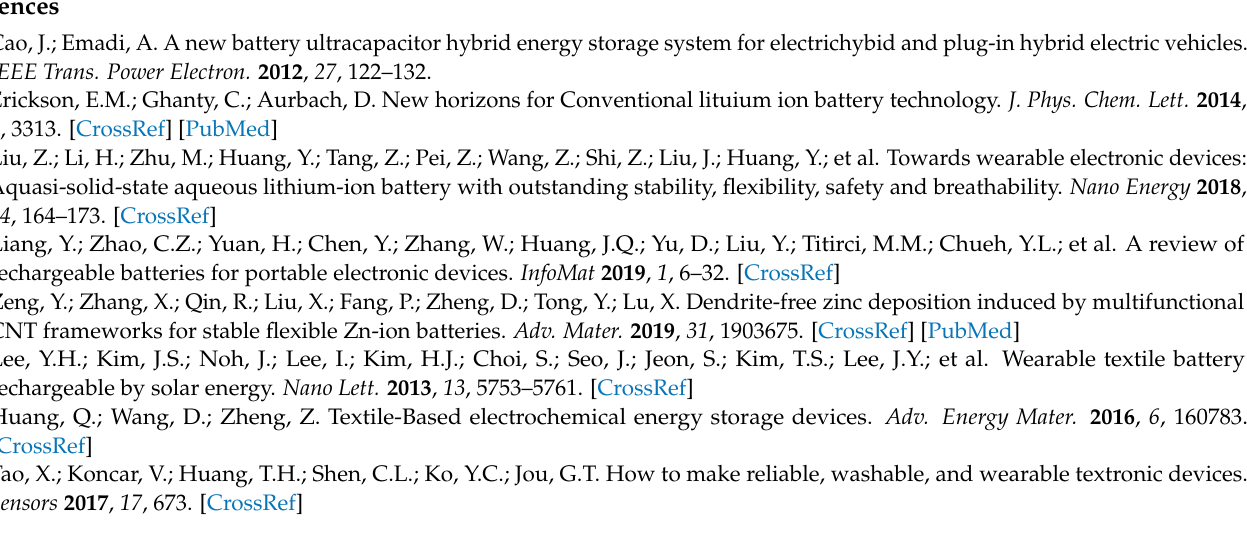
MnO 2 yarn cathode, Zn yarn anode., Figure S2: The resistance retention ratio ( R/R 0 ) of the MnO 2 yarn cathode, Zn yarn anode under the various bending angles from 0o to 180 ◦ , Figure S3: The resistance retention ratio ( R/R 0 ) of the MnO 2 yarn cathode, Zn yarn anode after 100 cycles with bending angle of 180 ◦ . Figure S4: The capacity retention ratio ( C/C 0 ) of the MnO 2 yarn cathode, Zn yarn anode after 100 cycles with Bending angle of 180 ◦